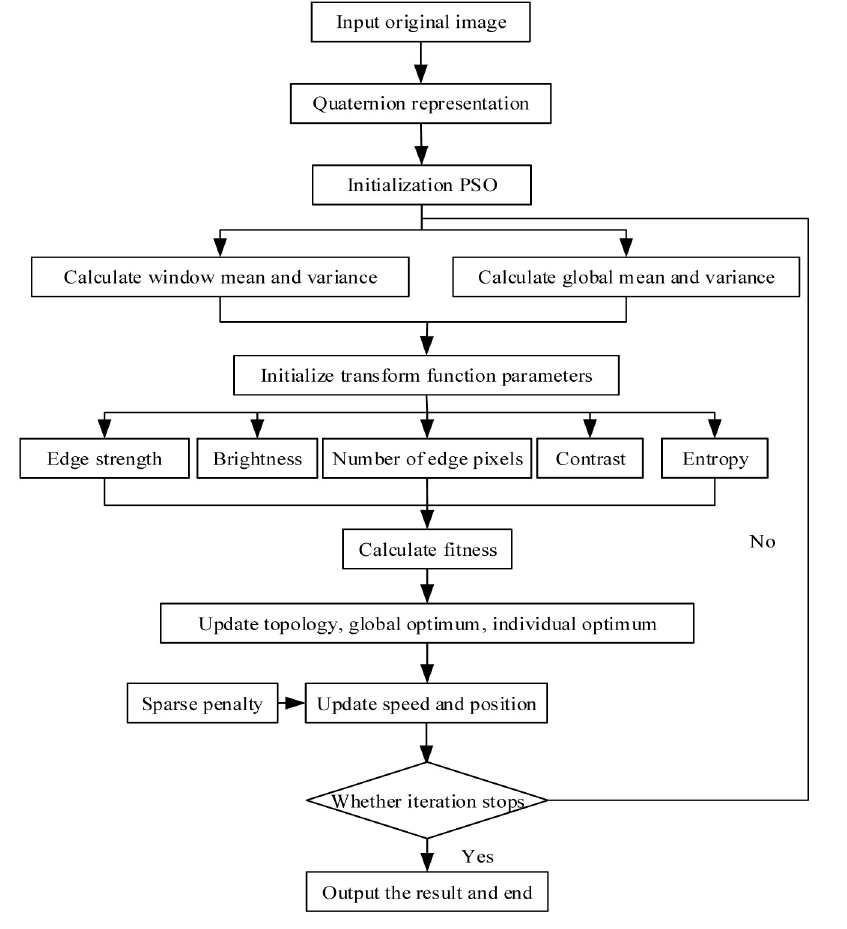
Fig 2. Flowchart of the